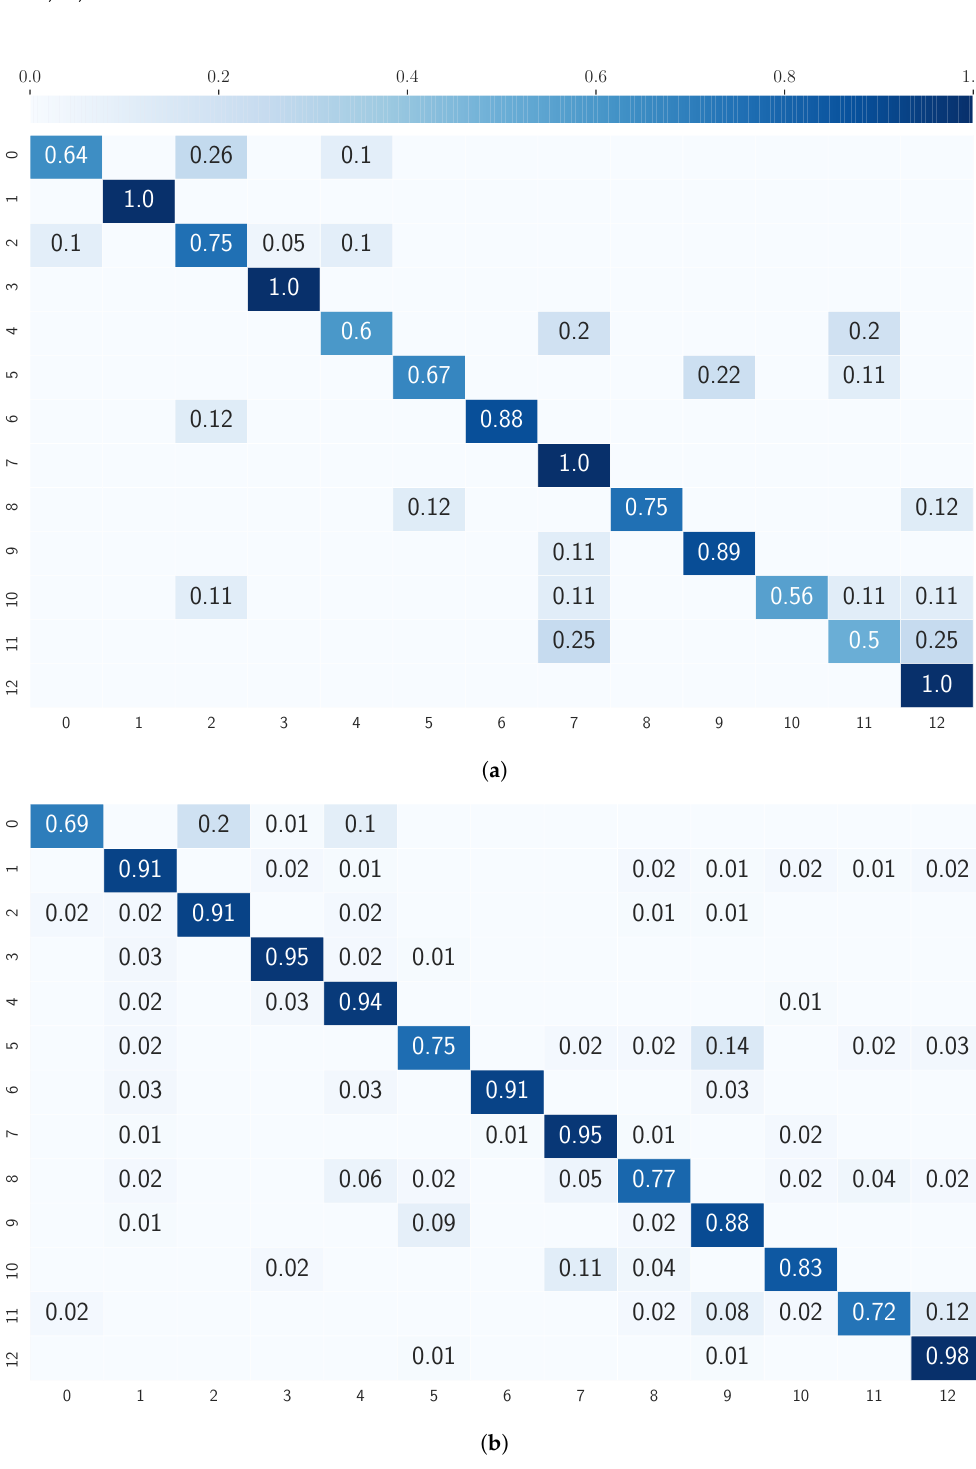
Figure 5. Normalized confusion matrix of activity recognition for the whole dataset with ( a ) ConvLSTM model on raw sensor signal and ( b ) ConvLSTM model on images (rows: ground-truth classes; columns: estimated classes). No value listed equals 0. Action list: (0) arm chest crossings; (1) arm circles; (2) arm head crossings; (3) arm raises; (4) arm stretches up; (5) cross stepping; (6) jumping jacks; (7) leg raises; (8) lunges; (9) side stepping; (10) squats; (11) sumo squats; and (12)